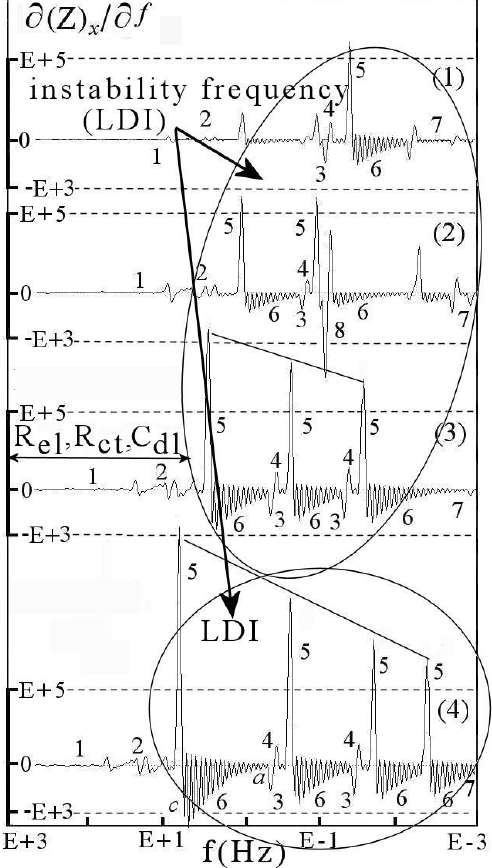
Figure 10. Instability events for impedance of palladium–hydrogen complex at potential in peak A. Views ( 1 ): − 0.25 V/NHE, ( 2 ): − 0.31 V/NHE, ( 3 ): − 0.37 V/NHE, ( 4 ): − 0.45